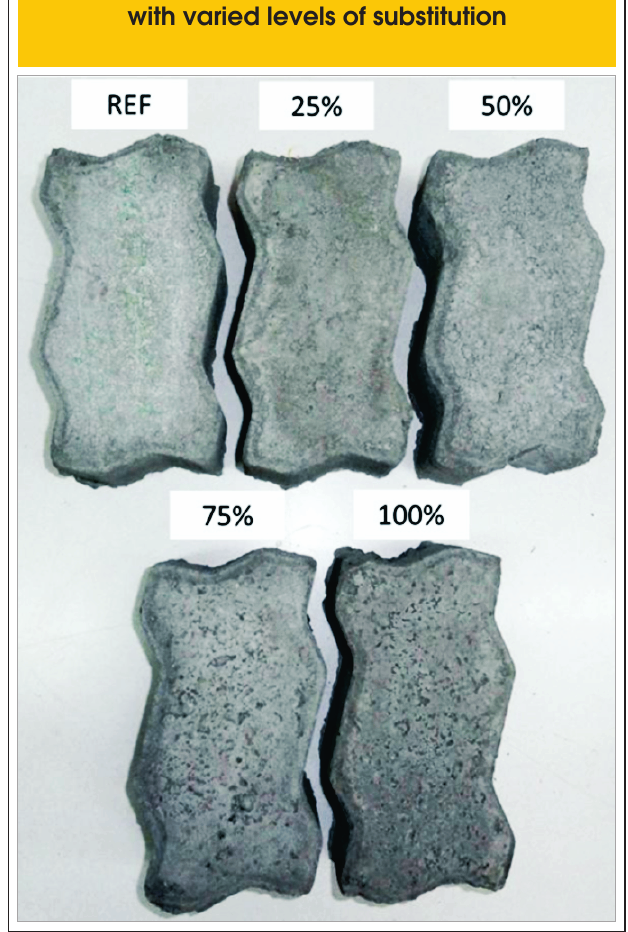
Figure 2 – Concrete paving blocks produced with varied levels of